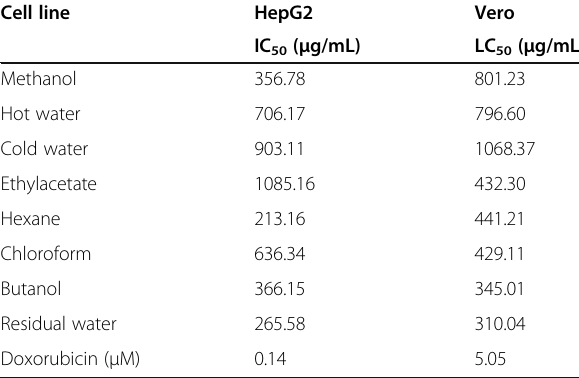
Table 1 Inhibitory/Lethal concentration (IC/LC 50 in μ g/mL) of extracts and fractions of the roots of Terminalia avicennioides and doxorubicin (positive control) in HepG2 human liver cancer and Vero monkey kidney cell